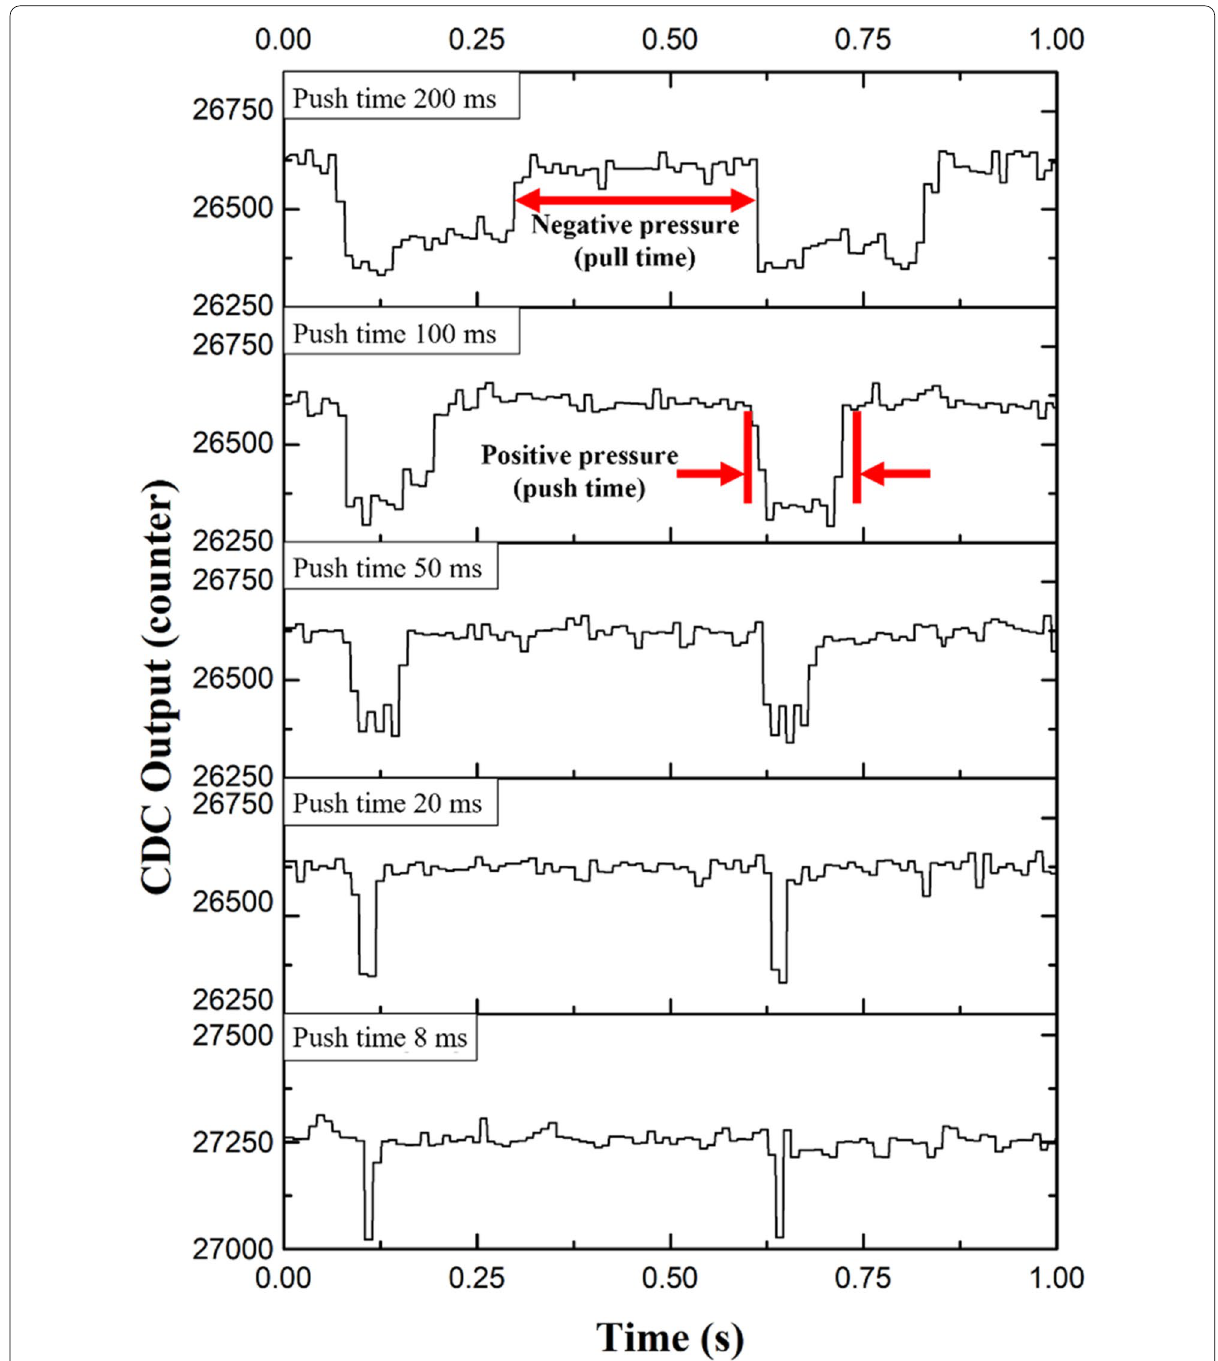
Fig. 4 Results of measured membrane sensor signal by controlling the push